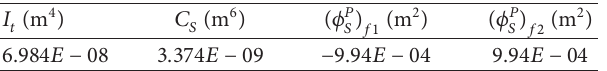
Table 3: Torsion, warping constants, and primary warping function at the interface lines of the stiffening